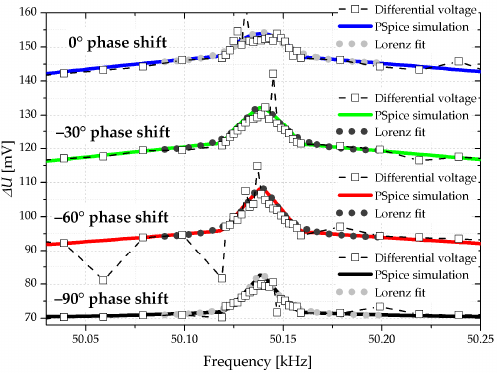
Figure 11. Comparison of the differential voltage of the Wheatstone bridge and the simulated voltage curve for the starting phase of − 90° to 0°. For reasons of clarity, the individual curves are shifted of 20 mV. To demonstrate the impact of φ start on the Q-factor the values are extracted from Figures 10 and 11 with a Lorenz fit and presented in Table 1.